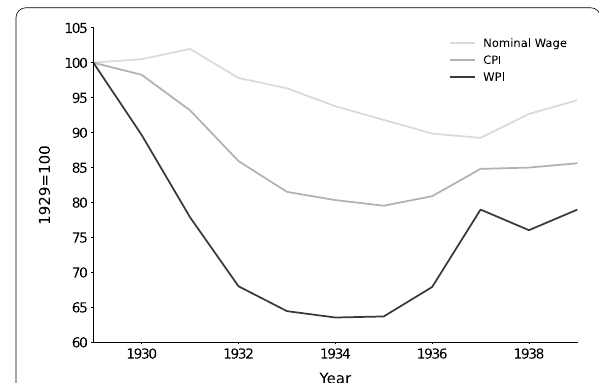
Fig. 2 Wholesale Price Index (WPI), Consumer Price Index (CPI) and Nominal Wage in Switzerland, 1929–39 (1929 SNB